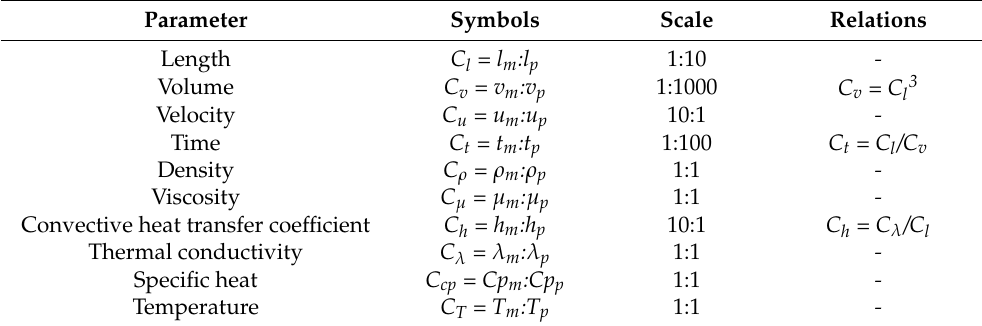
Table 3. Scale model test parameters.